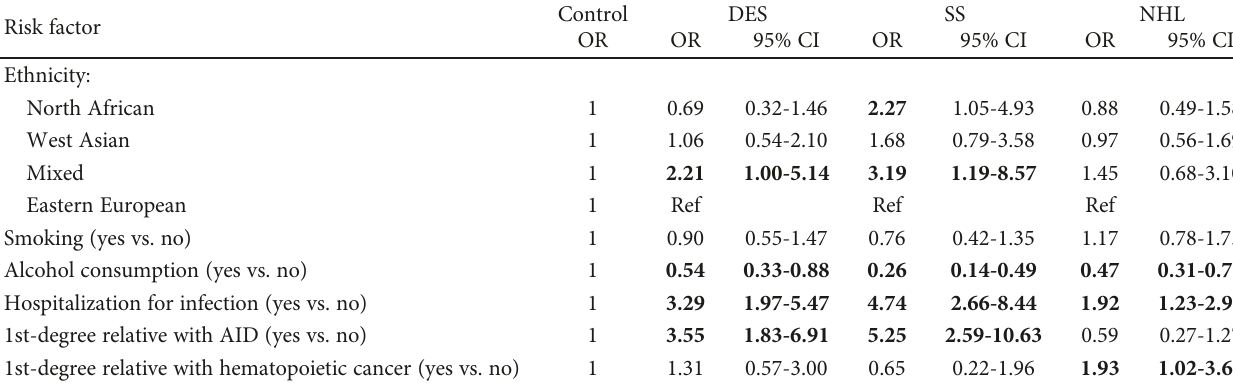
Table 3: Risk factors — multinomial regression